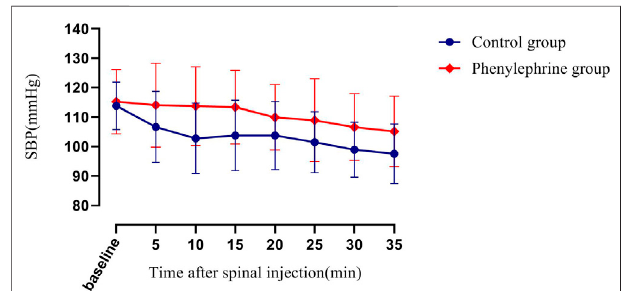
FIGURE 2 | Baseline systolic blood pressure (SBP) and the SBP in the fi rst 35 min after spinal induction is presented for the two groups. The area under the curve (mean ± SD) differed signi fi cantly between the two groups (4,930 ± 131 and 4,608 ± 113 min × mm Hg in the phenylephrine and control groups, respectively, p (cid:1)